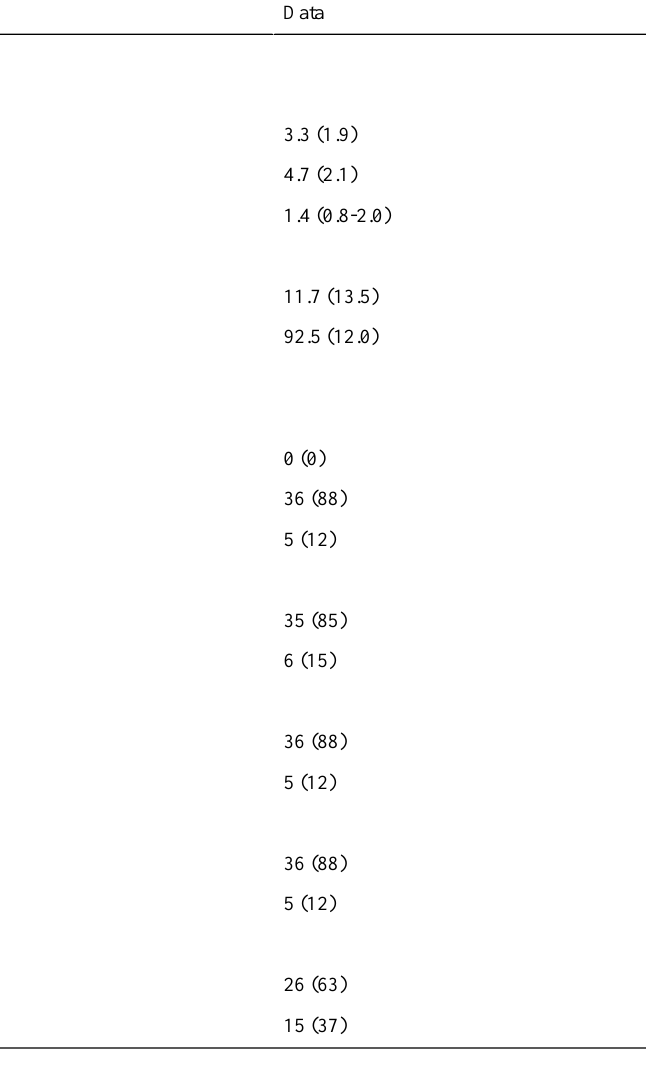
Table 3. Patient experience outcomes and